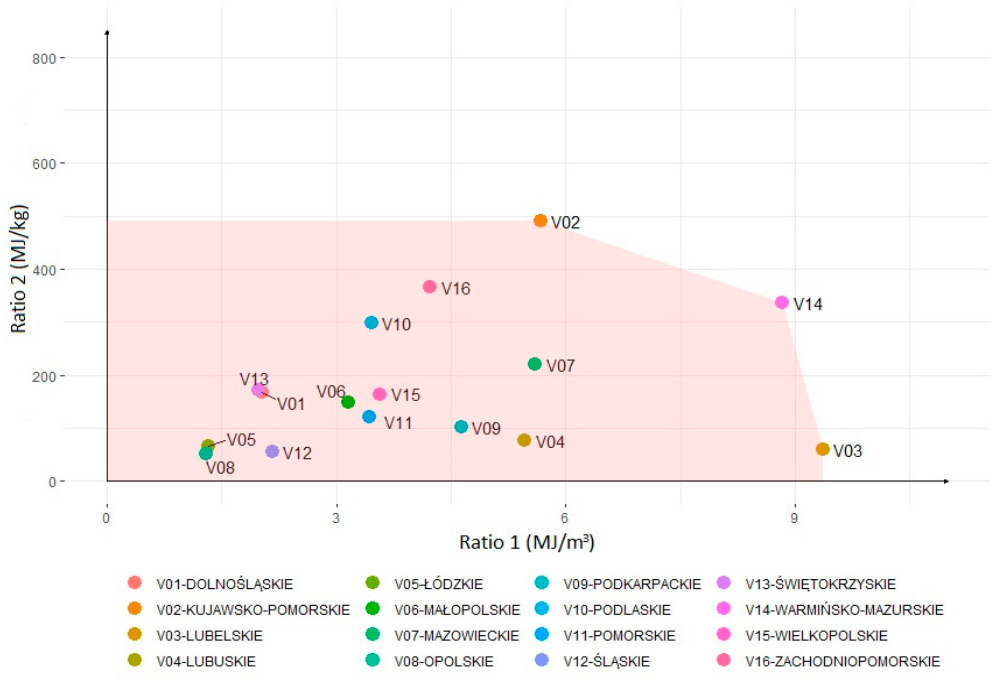
Figure 4. Efficiency of heat production from biogas and biomass in 2012 in Poland.